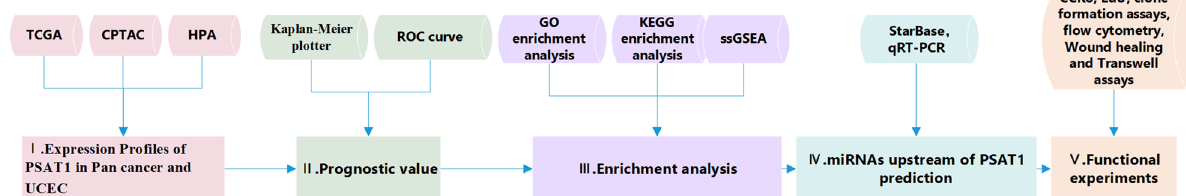
Figure 1. Study flow-chart.